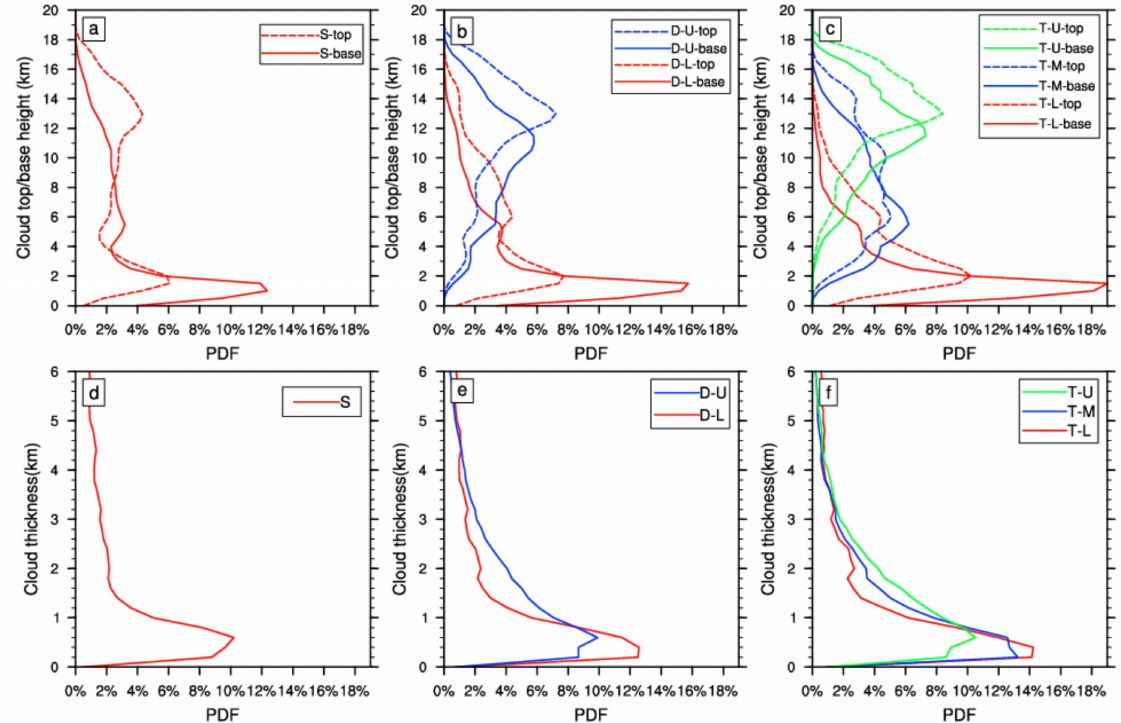
Figure 5. Probability density functions (PDFs) of cloud-top height (solid lines), cloud-base height (dashed lines) and cloud thickness for ( a , d ) single-layer clouds, ( b , e ) double-layer clouds, and ( c , f ) triple-layer clouds. The letters in the legends indicate different cloud layers. S, D, and T denote single-, double-, and triple-layer clouds, respectively. U/M/L represent the upper/middle/lower layers in multi-layer cloud